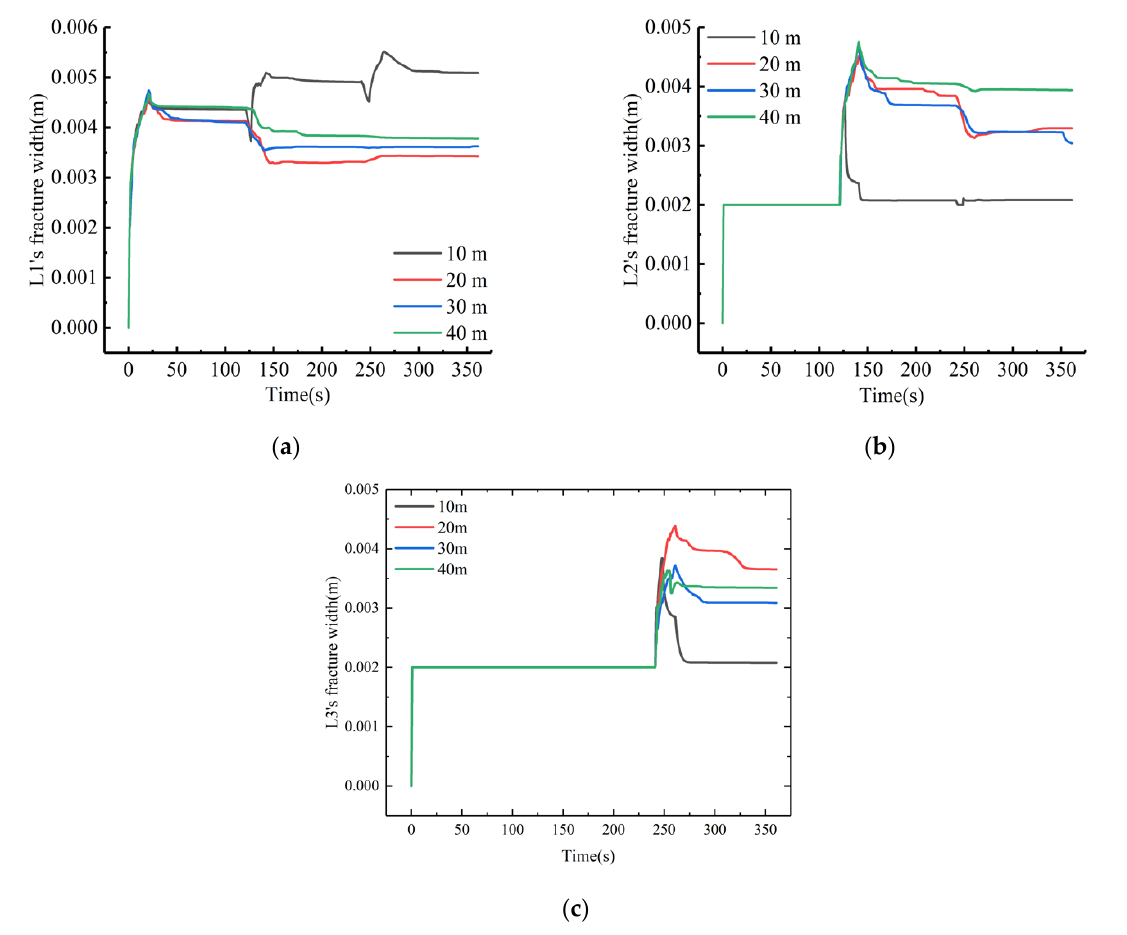
Figure 23. Variation curves of the fracture width of CBM reservoirs under various fracturing inter- vals. ( a ) L1, ( b ) L2, ( c ) L3. ( a ) L1, ( b ) L2, ( c )